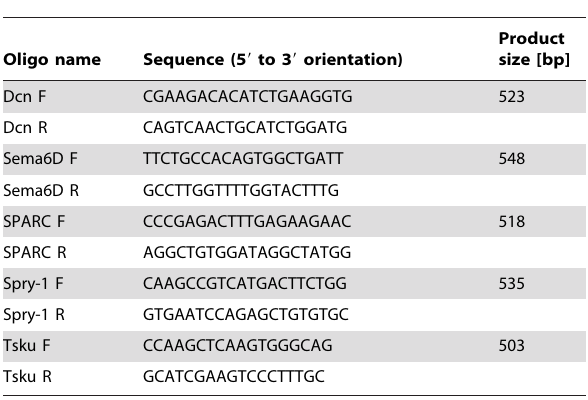
Table 2. Primer sequences for the whole mount in situ